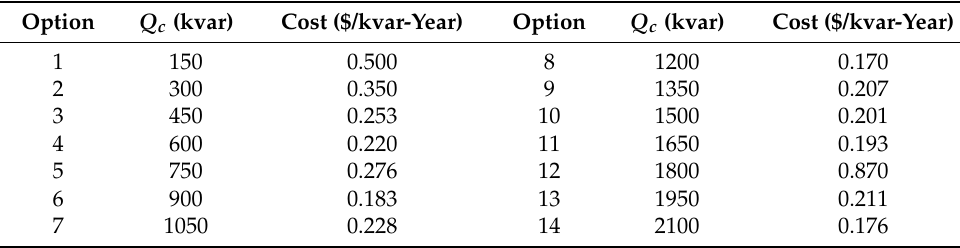
Table 4. Costs of the capacitors per